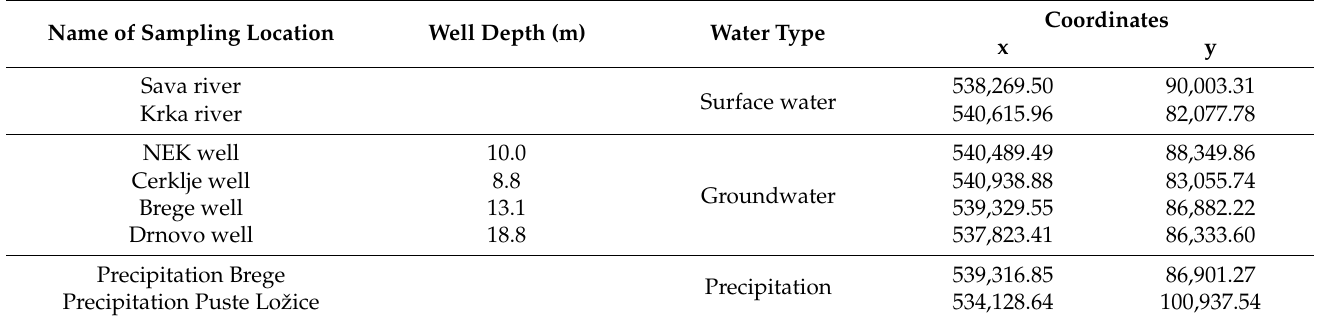
Table 1. Locations, types, and names of water samples in the study site (further information can be found in Figure